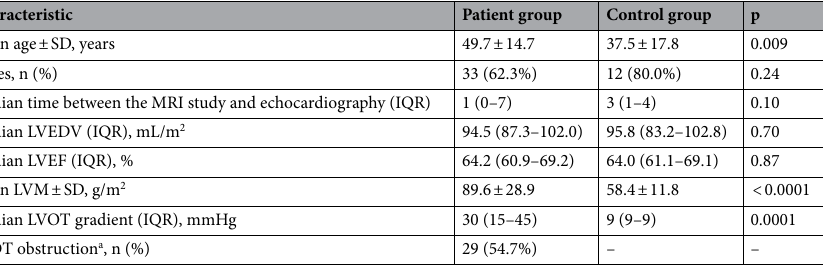
Table 1. Baseline characteristics of the study group and the control group. IQR, interquartile range; LVEDV, left ventricular end-diastolic volume; LVEF, left ventricular ejection fraction; LVM, left ventricular mass; LVOT, left ventricular outflow tract; MRI, magnetic resonance imaging; SD, standard deviation. a Peak LVOT gradient greater than or equal to 30 mmHg.